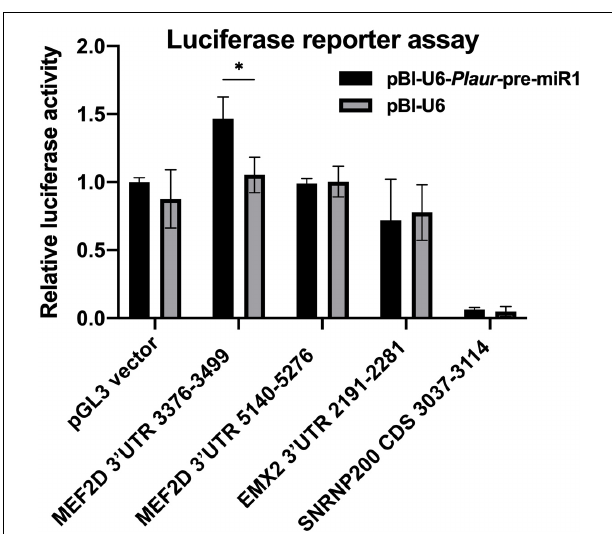
FIGURE 8 | Results of the luciferase reporter assay for the confirmation of specificity of Plaur-miR1-5p effect on its predicted targets. Neuro2a cells were co-transfected with pBl-U6-Plaur-pre-miR1 and pGL3 vector coding 3-UTR or CDS sequences. Empty vectors pBl-U6 and pGL3 were used as controls. Data were normalized by luciferase activity in Neuro2a cells co-transfected with pBl-U6-Plaur-pre-miR1 and pGL3 vectors. The data are presented as mean ± SEM ( n = 3) and compared using two-way ANOVA followed by Šídák’s multiple comparisons test with GraphPad Prism software. Statistical significance is indicated by bars and asterisks as follows: * p <